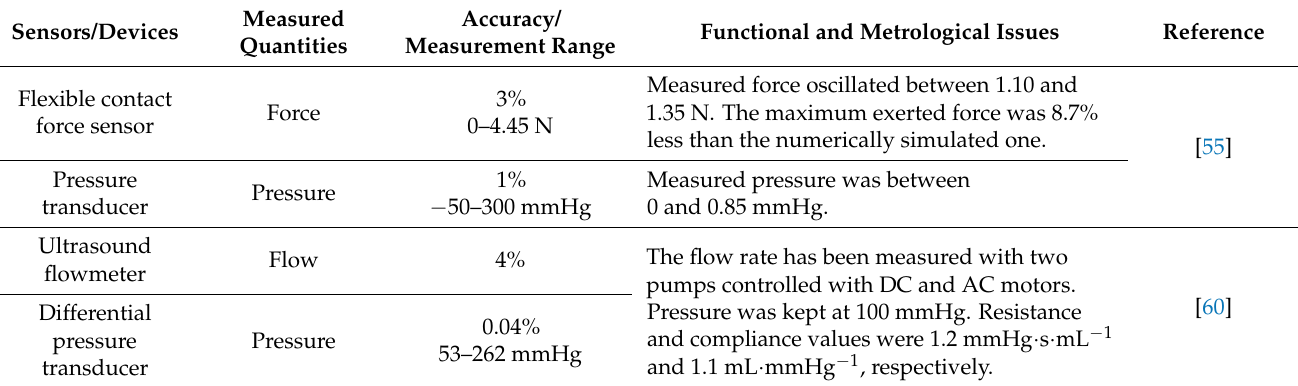
Table 5. Overview of clinician practice and device testing studies.